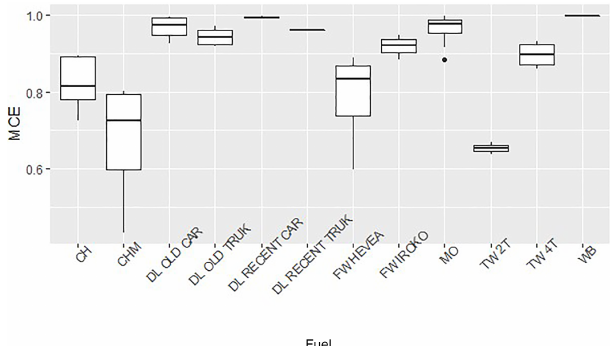
Figure 4. Modified combustion efficiency of different sources stud- ied (charcoal burning: CH; charcoal making: CHM; diesel: DL; wood burning: FW; gasoline: MO; two-wheeled vehicles: TW; and trash burning: